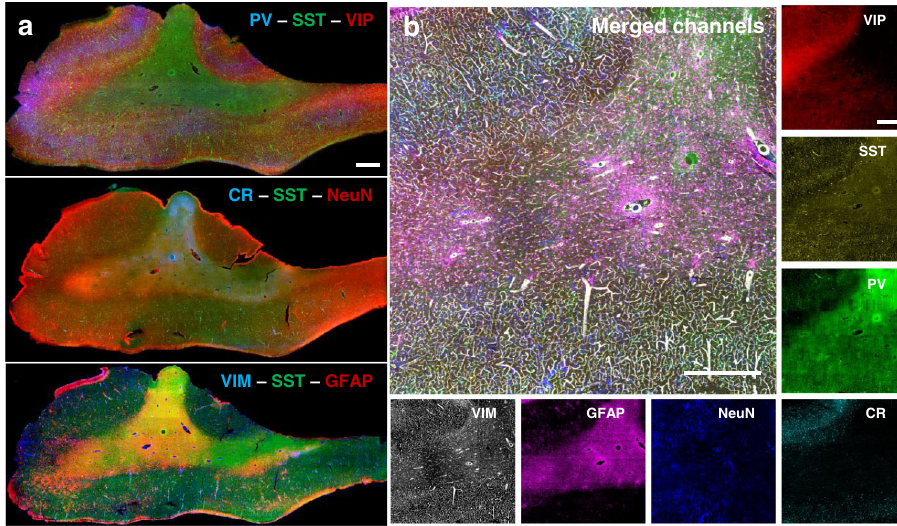
Fig. 5 SHORT allows multiple rounds of staining, imaging, and stripping of large portions of human brain slices. a Seven different antibodies were used across 3 sequential rounds of immunostaining, with SST employed as fi ducial markers in each round. Round 1: PV — SST — VIP; round 2: CR- SST — NeuN; round 3: VIM — SST — GFAP. Scale bar = 1 mm. b The merged image shows a particular of the white and grey matters labeled with VIP, SST, PV, CR, NeuN, GFP, VIM. MIP of 70 slices. Scale bar = 100 μ